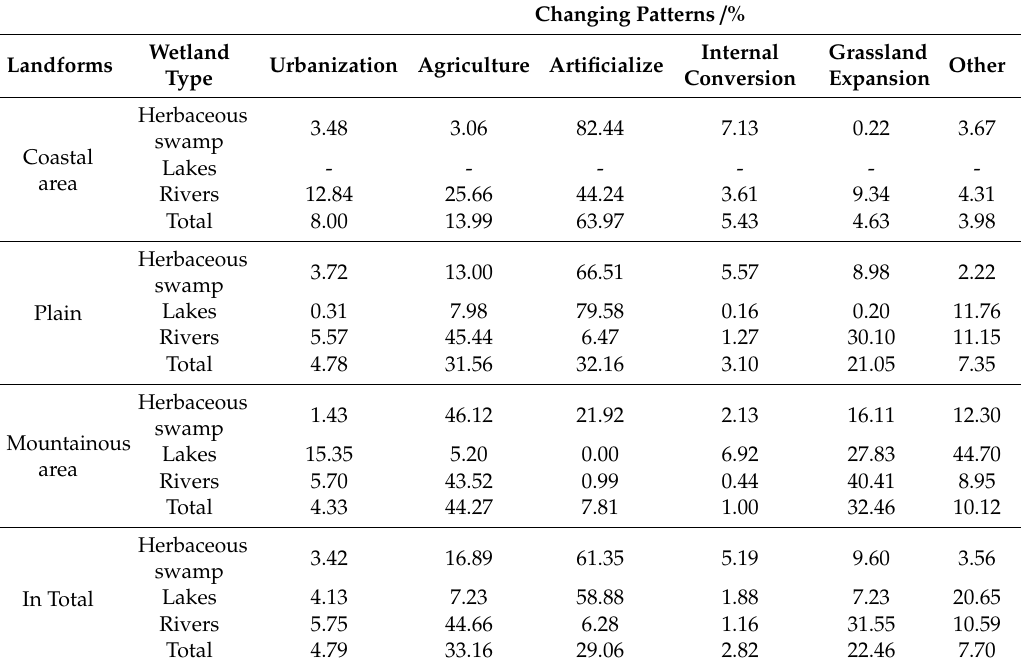
Table 2. Contribution of di ff erent driving forces calculated as the percentage change between 2000 and 2015 in in di ff erent geographic areas in Beijing-Tianjin-Hebei region (BTH).